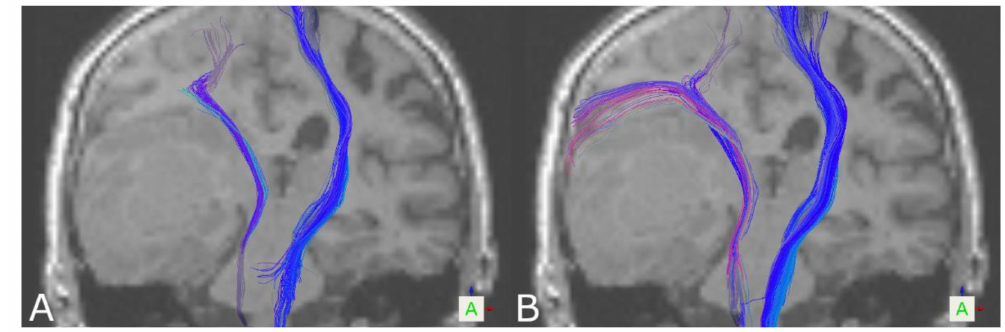
Figure 2. Tractography results of the CST based on DTI ( A ) and DKI ( B ) for a patient with a right temporal glioblastoma WHO IV, in close vicinity of the CST (coronal view).